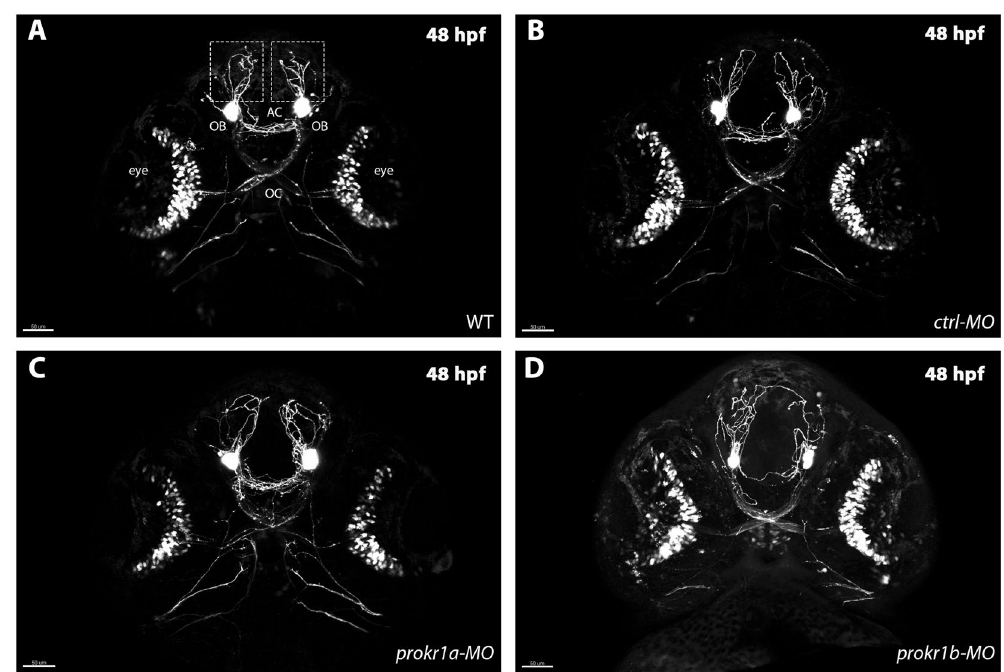
Figure 3. Injection of ctrl-MO ( B ) or prokr1a-MO ( C ) does not affect GnRH3 neuron fibers, as they look comparable to uninjected WT ( A ) embryos. In contrast, knockdown of prokr1b ( D ) causes alteration in axons migration of the rostral part (dotted square in Fig A) and at the level of the anterior commissure (AC) of the embryos. OB = olfactory bulbs, OC = optic chiasm, AC = anterior commissure. Scale bar = 50 µ